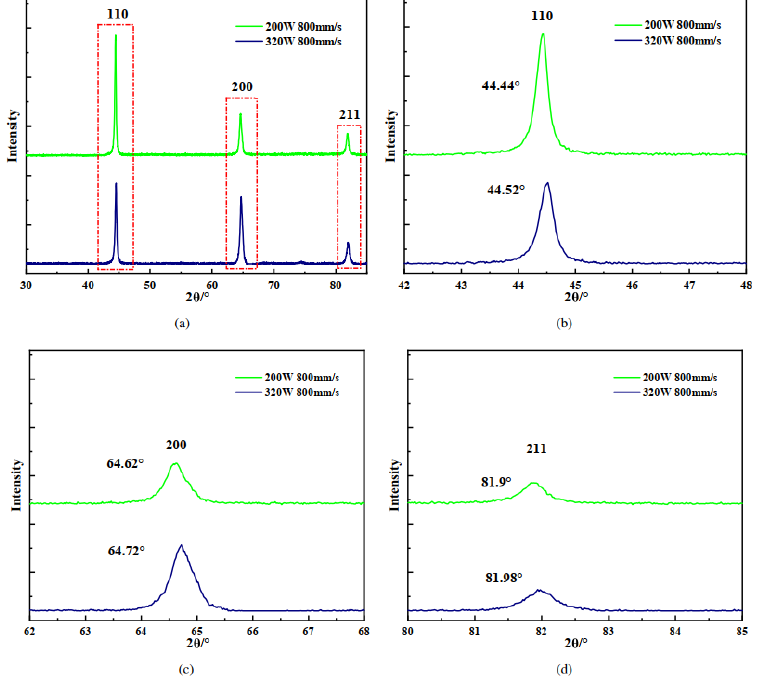
Figure 5. ( a ) XRD patterns of the as-deposited RAFM steels, ( b ) enlargement of the (110) peak, ( c ) enlargement of the (200) peak, and ( d ) enlargement of the (211) peak. ( c ) enlargement of the (200) peak, and ( d ) enlargement of the (211) peak.